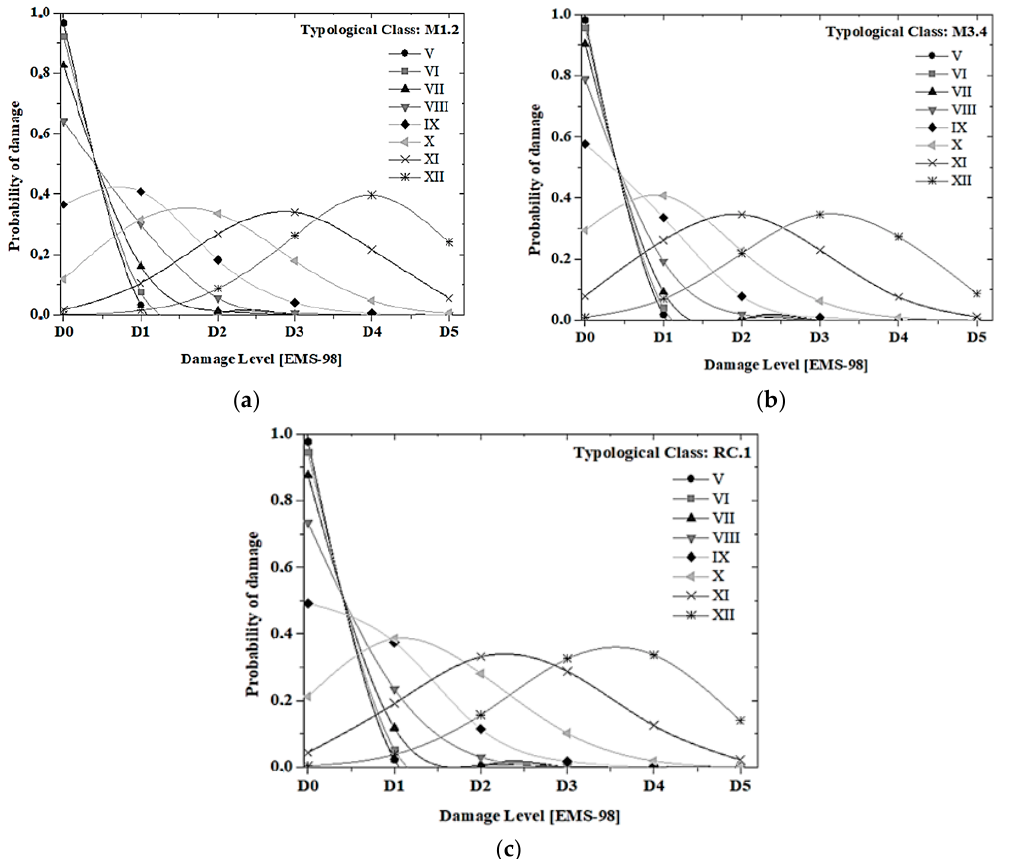
Figure 6. Damage Probability Matrices (DPM) for ( a ) M1.2, ( b ) M3.4 and ( c ) RC.1 typological classes.